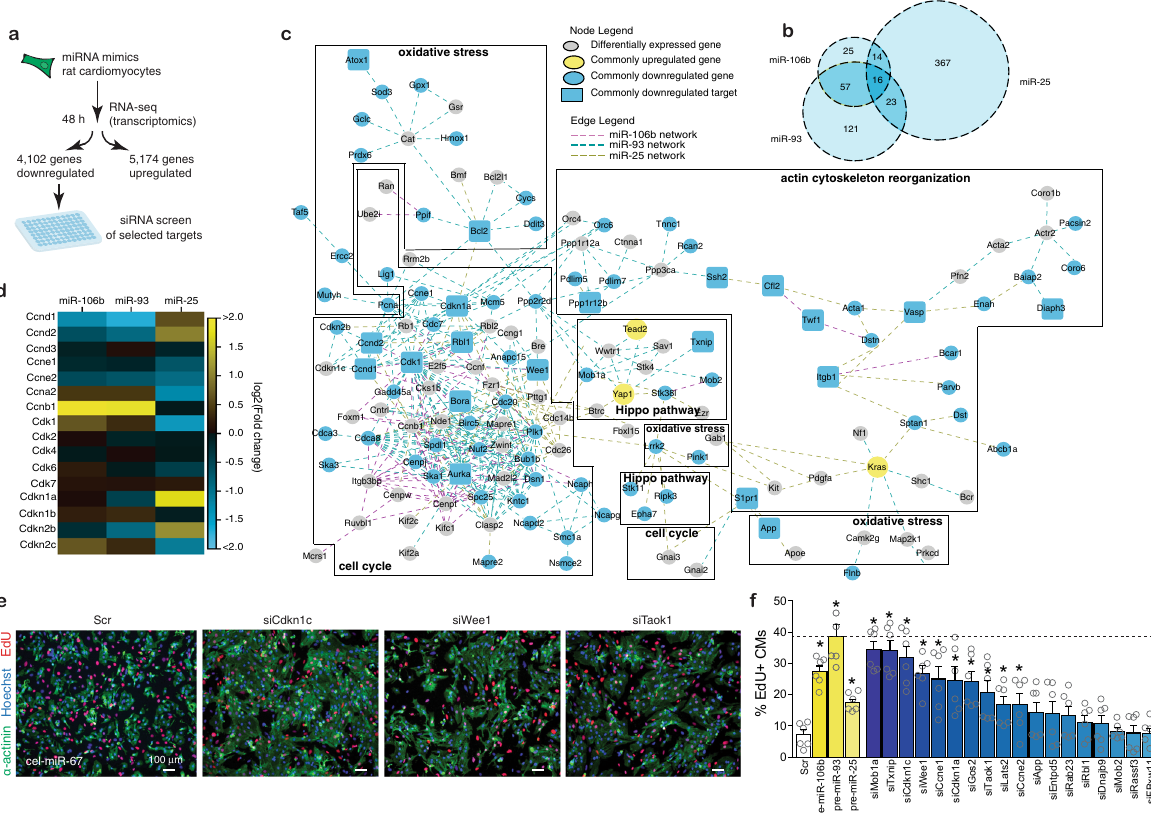
Fig. 5 The miR-106b~25 cluster suppresses cell cycle inhibitors. a Work fl ow for the experiment and miRNA target validation. b Venn diagram showing the relationship between the sets of downregulated genes with miR-106b , miR-93, or miR-25 seed regions and a 1.3-fold change cut-off with respect to cel-miR- 67 . c A compartmentalized network of differentially expressed genes involved in cell cycle regulation. Each connection is color-coded according to the miRNA that regulates the differentially expressed gene (magenta for miR-106b , cyan for miR-93 and dark yellow for miR-25 ). Genes indicated by blue circles are downregulated by at least one miRNA while downregulated genes shown in blue squares are found to be bioinformatic targets by at least 1 miRNA. Genes represented by yellow circles are upregulated genes by all three miRNAs. d Heatmap representation of cell cycle regulators differentially expressed by miR-106b~25 relative to cel-miR-67 . e EdU staining of rat CMs treated with selected siRNAs. f Percentage of proliferating rat CMs after siRNA treatment, mean ± s.e.m. represents n = 6 biologically independent wells examined over one independent experiment. * P < 0.05 vs corresponding control group (error bars are s.e.m.). Statistical analysis consisted of a two-tailed Student ’ s t -test ( f ). Source data are provided as a Source data fi